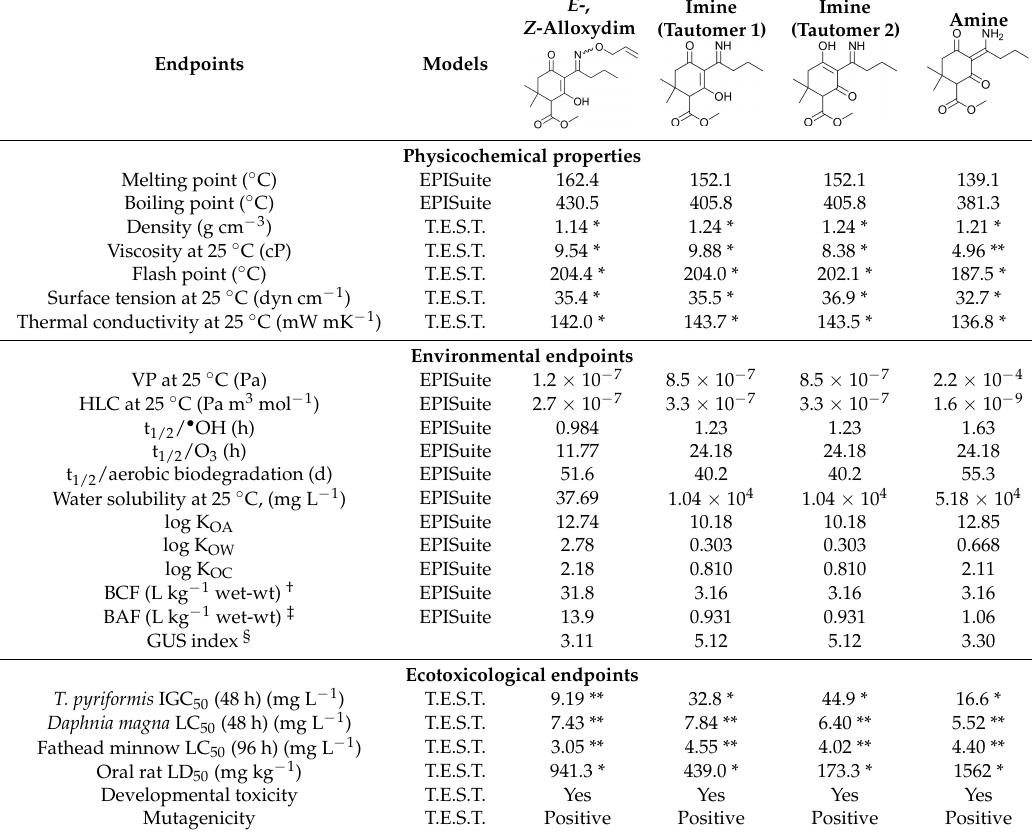
Table 2. Estimation of several physicochemical properties and environmental and ecotoxicological endpoints for alloxydim and its byproducts using EPI Suite TM or T.E.S.T. models. The mean absolute errors are determined in both the entire training set and external test set of the T.E.S.T.